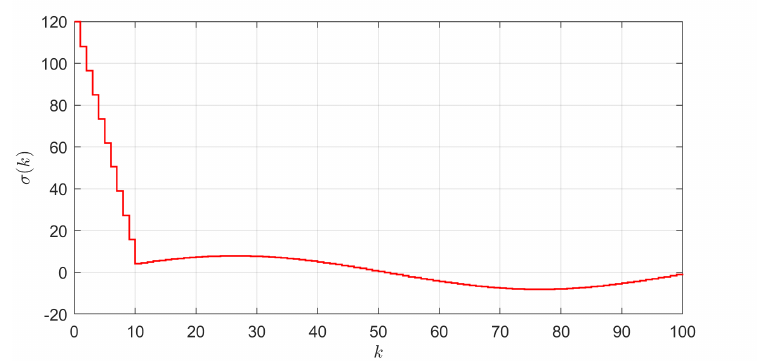
Figure 6. Sliding